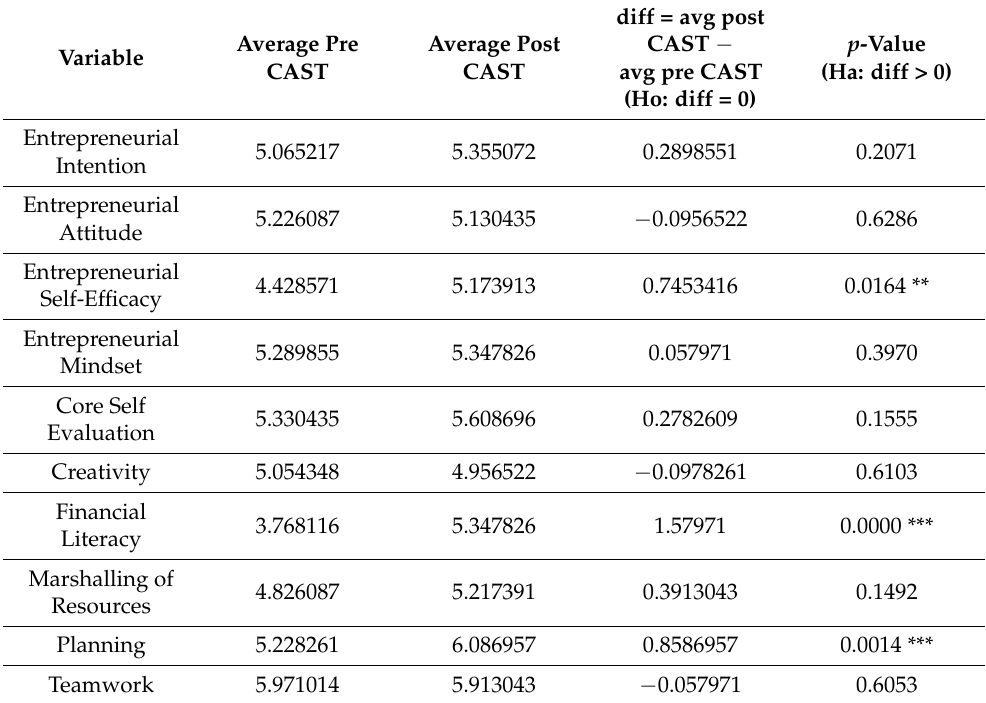
Table A8. Output of t -tests on entrepreneurial characteristics, pre- and post-course, of the students who worked on patented technologies.